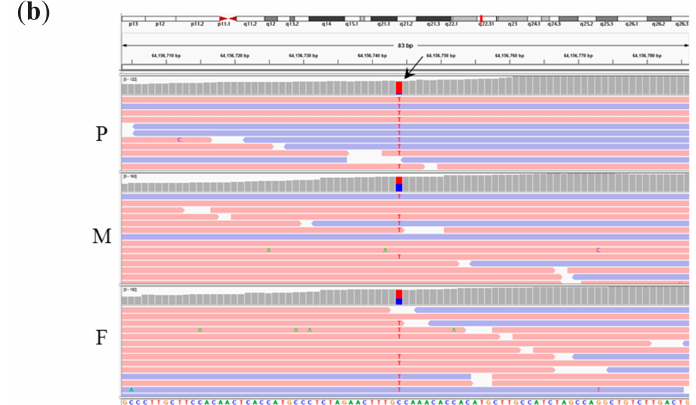
Figure 4. Trio-WES of ( a ) Family 1 and ( b ) Family 2 identified an identical biparental-origin homozygous mutation in PPIB (NM_000942.5:c.509G>A(p.G170D), corresponding to chr15 g.64156744C>T, hg38) (arrow) in both patients. P, M, and F indicate patient, mother, and father respectively.